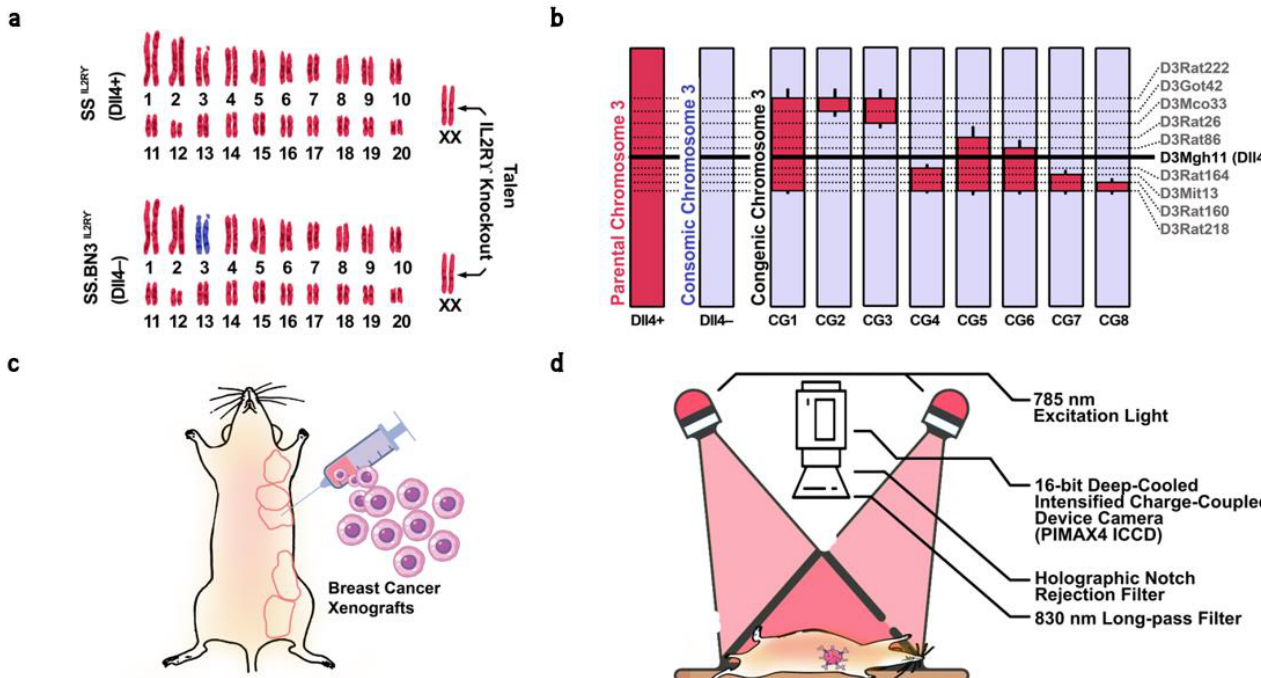
Figure 1. ( a ) Schematic representation of the SS(Dll4+) and SS.BN3(Dll4−) genomes modified by TALEN-mediated editing of the IL2R Ƴ gene, showing chromosomes derived from SS (red) or BN (blue). ( b ) Schematic representing congenic strains and vascular-specific Dll4 protein expression, generated by introgressing BN(Dll4−) chromosome 3 (blue) into the SS IL2R Ƴ - strain (red) via marker- assisted breeding. Thin black bars represent confidence intervals of chromosomal regions that could be BN or SS. The horizontal black line indicates the location of vascular-specific Dll4 protein on chromosome. The dotted lines represent the location of SSLP markers. ( c ) Transgenically labeled human MDA-MB-231 triple-negative breast cancer cells were orthotopically implanted in the mam- mary fat pad of parental, consomic, and congenic rats. ( d ) Schematic diagram of the dynamic epiflu- orescence NIR imaging setup. A bifurcated optical fiber bundle delivers 785 nm excitation light for uniform illumination of the rat body surface. A 16-bit deep-cooled intensified charge-coupling de- vice camera was used to image the rats through computer-controlled software. 3. Materials and Methods All methods have been carried out in accordance with relevant guidelines and regu- lations. Approved protocols by the Medical College of Wisconsin Institutional Biosafety Committee (IBC) and Institutional Animal Care and Use Committee (IACUC) were fol- lowed. All live animal experiments are reported per the ARRIVE guidelines ’ recommen- dations [51]. All results were rigorously adjusted for multiple comparisons. 3.1. Animals All animal protocols employed in this study were approved by the Institutional An- imal Care and Use Committee (IACUC), Medical College of Wisconsin (MCW). The MCW has an Animal Welfare Assurance (Assurance number D16-00064 (A3102-01)) on file with the Office of Laboratory Animal Welfare, National Institutes of Health (NIH). Animal ex- periments were performed according to the relevant guidelines and regulations and in compliance with the Guide for the Care and Use of Laboratory Animals published by the US National Institutes of Health (NIH publication no.85 – 23, revised 1996). SS.BN3 rats were developed as part of the Consomic Xenograft Model at the Medical College of Wis- consin (MCW) [40]. SS and SS.BN3 rats were purchased from the Rat Research Models Service Center at the Medical College of Wisconsin [52]. All rats were provided reverse osmosis hyper-chlorinated water ad libitum. All animal experiments were performed on